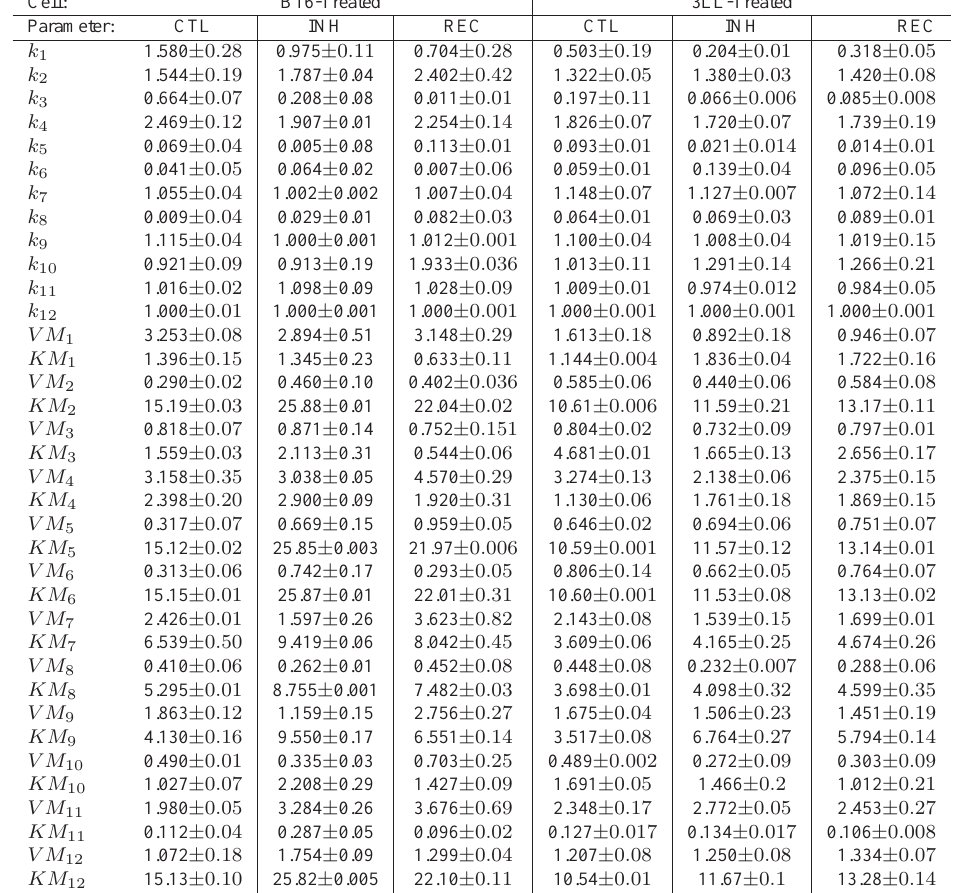
Table 5: Estimated parameter values for mouse melanoma and 3LL carcinoma metabolites which is used in our comparative